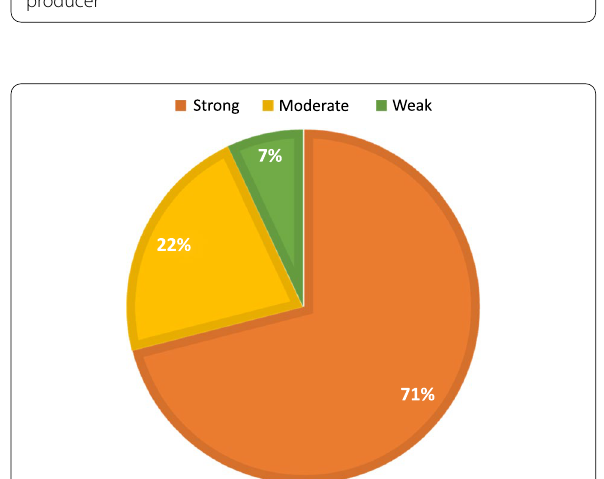
Fig. 3 Relative percentages of S. mutans isolates showing weak, moderate, and strong